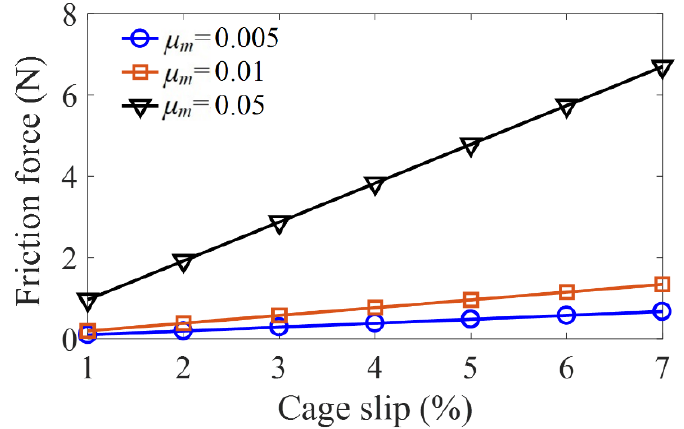
Figure 9. Effects of cage slip under different friction coefficients ( ω s = 2000 rpm, W = 2000 N).